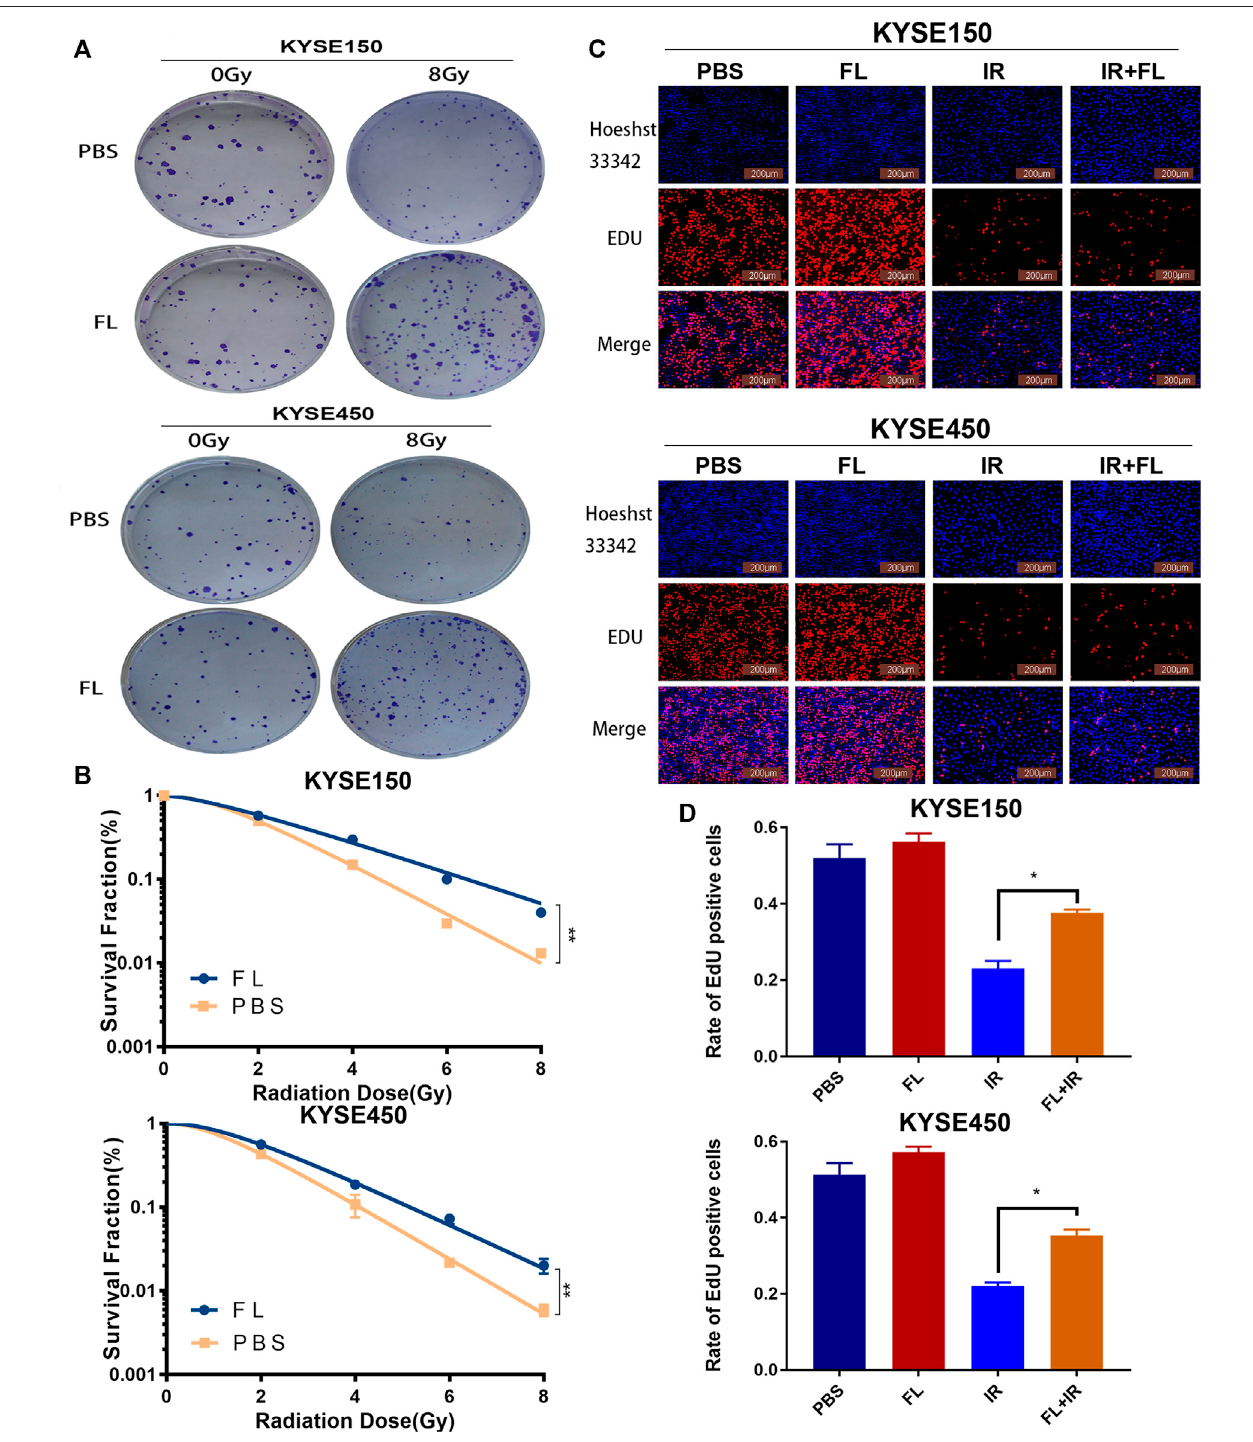
FIGURE 2 | FL promotes radioresistance of ESCC cells in vitro. (A) The clonogenic survival assays in PBS groups or 200 ng/ml FL administration for 24 h groups after 24 h of 8Gy radiation. (B) The survival curves calculated and fi tted to a multi-target single-hit model from (A) . (C) the EdU incorporation assays in ESCC cells (Red fl uorescence: EdU-positive cells; Blue fl uorescence: total cells). (D) Mean rate of EdU positive cells in histogram. Mean ± SEM, N (cid:2) 3, * p < 0.05, ** p < 0.01.